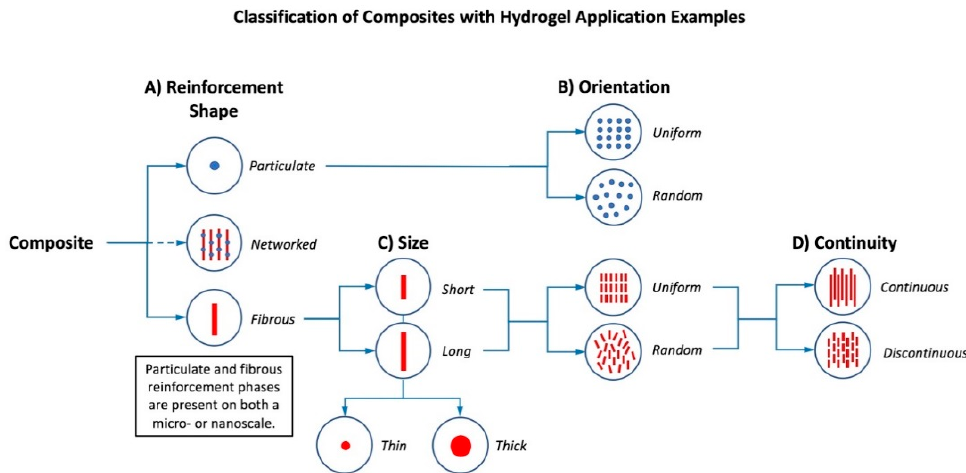
Figure 2. Hierarchical classification of composite hydrogels based on their reinforcing phases at micro and nanoscales. ( A ) Reinforcement shape may be particulate, fibrous, or a hybridization of the two [24–28]; ( B ) both particulate and fibrous reinforcement has either uniform or random orientations [29]; ( C ) fibers in a reinforcing phase can be classified as long or short and further organized based upon fiber diameters or thicknesses; ( D ) within a composite, fibers may have continuous or discontinuous patterns [8].